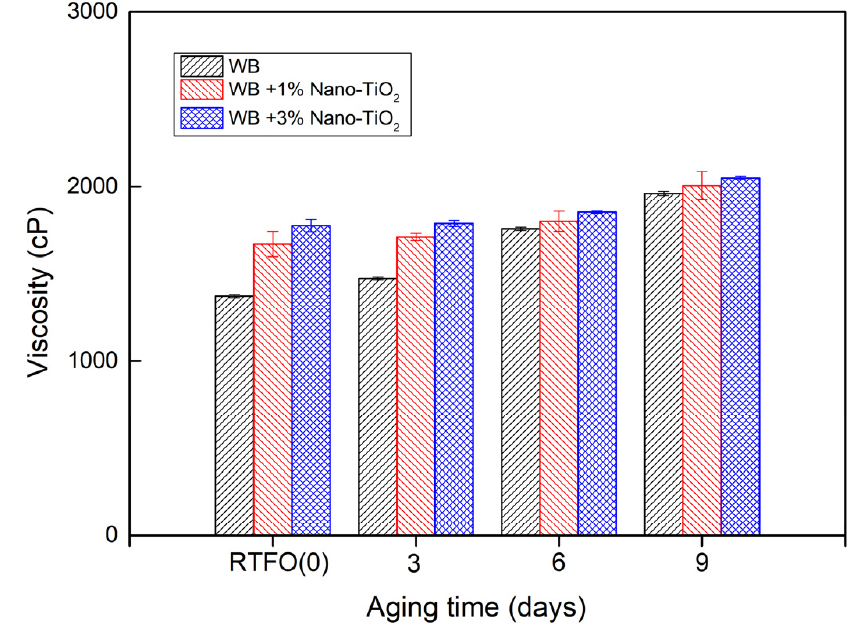
Figure 2. Viscosity of UV-aged binders at 135 °C .